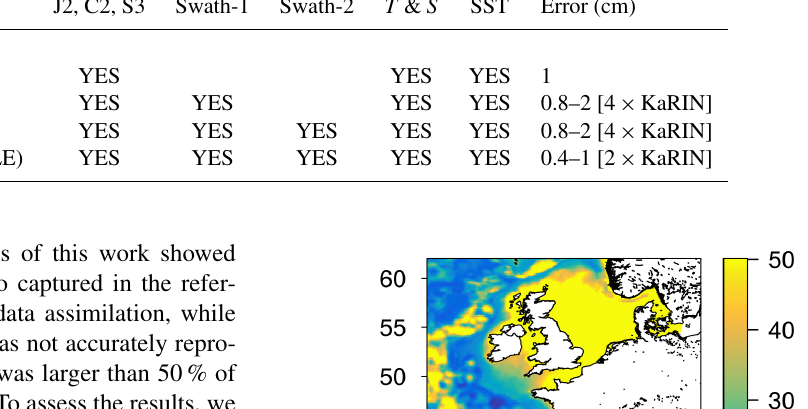
Table 3. OSSEs experimental set-up. The rows show the names of the relevant experiments, whereas the columns detail the observations considered in the analysis. Column 1 shows the nadir altimeters considered in the OSSEs: Jason-2 (J2), CryoSat-2 (C2), Sentinel-3a (S3). The last column shows the instrumental error used to simulate the altimetry data. OSSE2–OSSE4 represent the range of across swath errors considered for the wide-swath altimetry data. The sections in parentheses represent the following: “Free” is the reference simulation without data assimilation; “3N” denotes the three nadir altimeters; “1S” is one wide-swath; “2S” is two wide-swath; and “LE” is lower radar interferometer error. In sections in brackets represent the order of magnitude of the wide-swath altimetry error selected in the OSSEs with respect to the error of the KaRIN instrument (NASA/CNES SWOT mission). J2, C2, S3 Swath-1 Swath-2 T & S SST Error (cm)